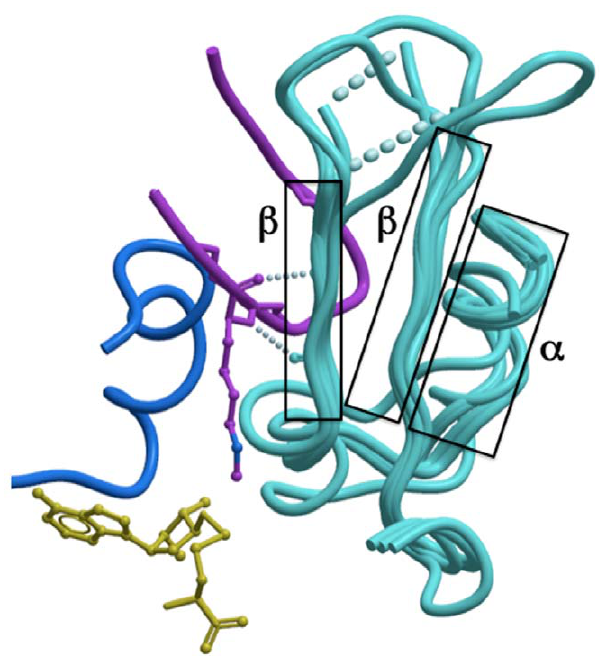
Figure 4. The I-SET domain is relatively rigid and structurally conserved. Structural superimposition of the ternary GLP structure with G9a or Suv39H2 in complex with co-factor and with the apo-structure of PRDM2 shows that the I-SET (cyan) conformation is conserved. The backbone atoms engaged in a double hydrogen-bond with the substrate lysine observed in all available HKMT-peptide complexes are already positioned in the absence of peptide or co-factor.